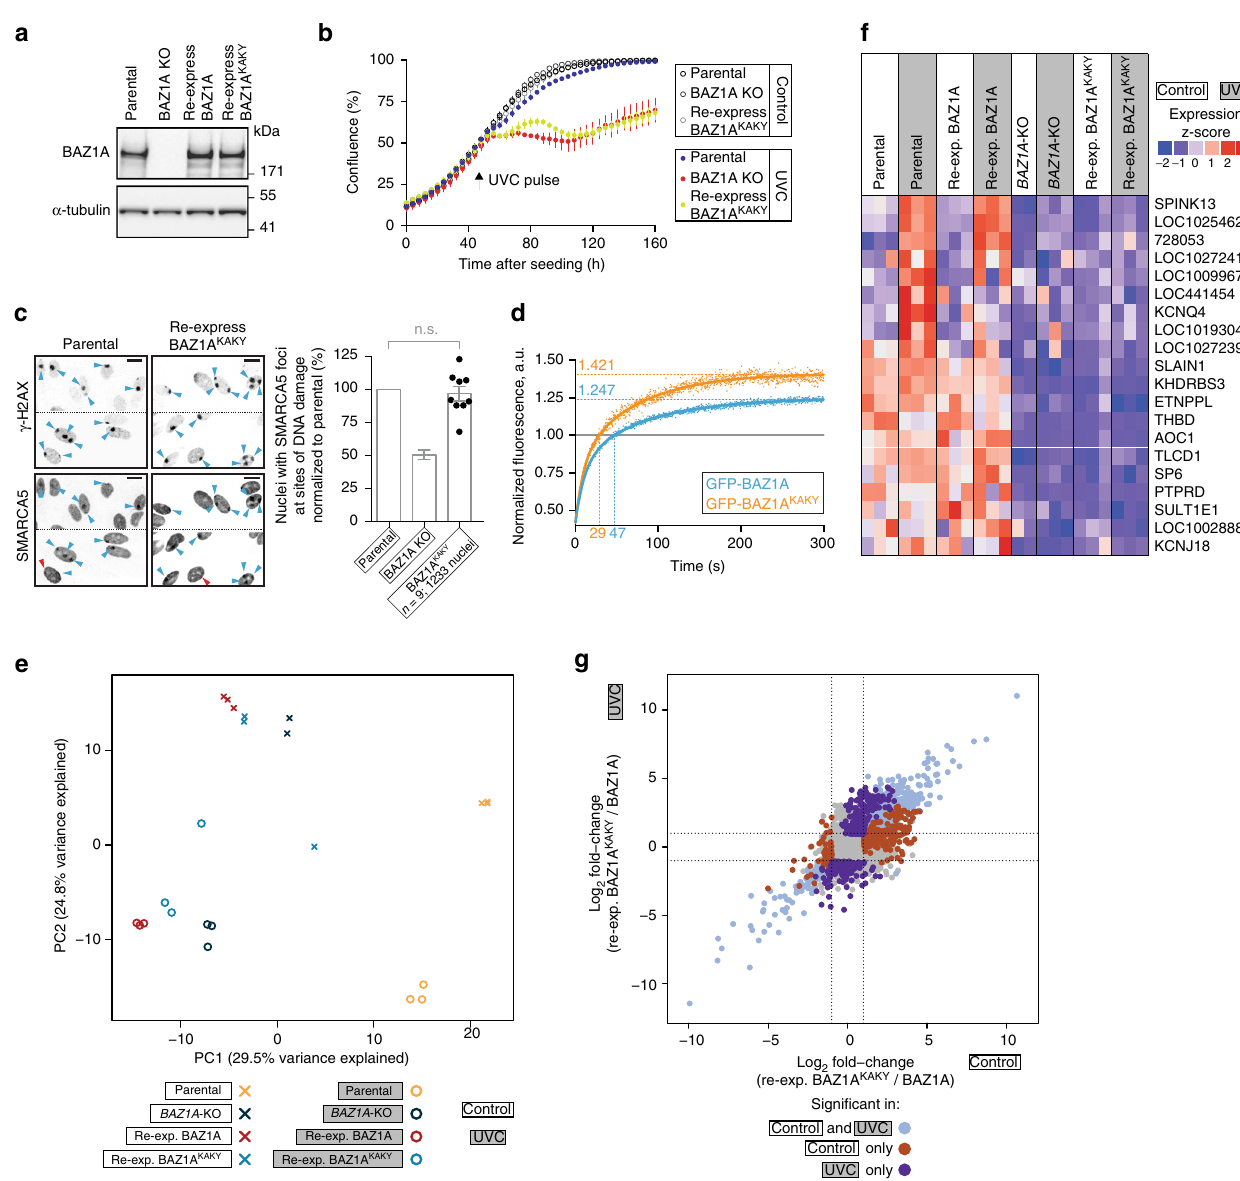
Fig. 7 Function-altering PHD substitutions are detrimental to the cellular functions of BAZ1A. a Western blot analysis of BAZ1A expression in parental, BAZ1A -KO, and BAZ1A -KO cells engineered to re-express BAZ1A KAKY . b – d Con fl uence of the indicated cell line measured over time, before, and after a pulse of UVC light. c Accumulation of endogenous SMARCA5 at sites of DNA damage as in Fig. 2c, d. Scale bar , 20 μ m. Histograms represent the mean value ± s.e.m. normalized to recruitment in parental cells. P- values were calculated using a two-tailed Mann – Whitney test; n.s . not signi fi cant ( P > 0.05). d Accumulation of GFP-fusion BAZ1A proteins to sites of laser irradiation in live cells. The fl uorescence signal at site of irradiation is normalized to the signal of a non-irradiated area. Signal above 1 indicates accumulation at site of damage. Numbers on the x -axis and y -axis represent the time at which the fl uorescence value equals 1 and the maximum value (plateau determined by fi tting), respectively. e PC analysis of the transcriptional pro fi les of parental, BAZ1A -KO, re-expressing BAZ1A wild-type and re-expressing BAZ1A KAKY cells, before and after DNA damage. For each cell line, the fi rst and second PCs (explaining the highest percent of variance) are reported for 2 – 3 independent RNA extractions. f Heat map showing the expression pro fi les of genes that are signi fi cantly upregulated in parental and re-expressing BAZ1A cells after UVC treatment compared to BAZ1A KAKY and BAZ1A -KO cells. The genes that are signi fi cantly downregulated for the same comparison are shown in Supplementary Fig. 8d. In both cases, only genes with the same expression pro fi les in parental and re-expressing BAZ1A cells, as well as BAZ1A -KO and BAZ1A KAKY cells are reported. Individual columns correspond to independent RNA extractions. g 4-way comparison showing the log 2 fold-change between BAZ1A -KO cells engineered to re-express BAZ1A wild-type or the BAZ1A KAKY mutant under control conditions on the x -axis compared to UVC conditions on the y -axis. Points are colored according to differential expression signi fi cance, points in gray do not satisfy signi fi cance cut-off ( P < 0.01, absolute log 2 fold-change >